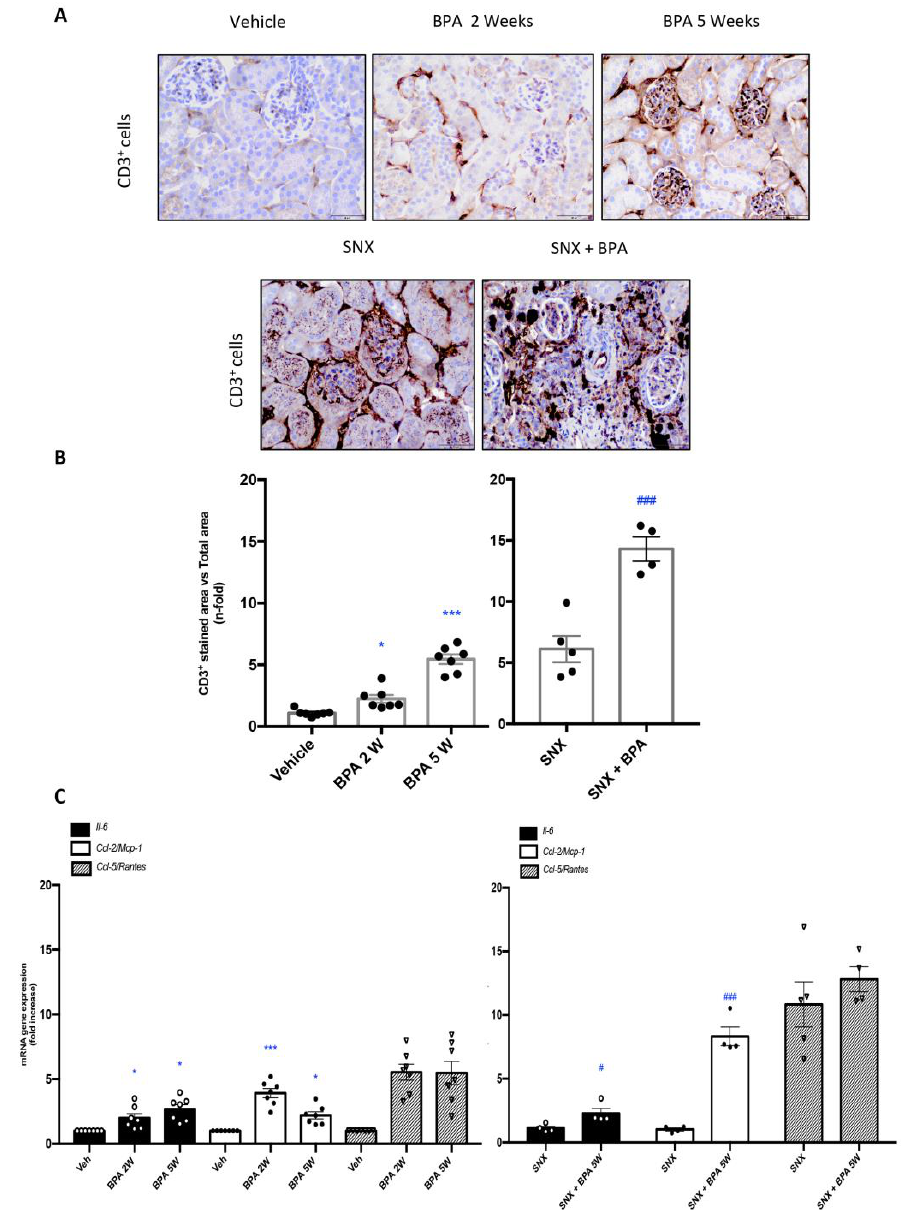
Figure 2. Systemic chronic administration of BPA causes interstitial inflammatory cell infiltration in the kidney and increases renal expression of proinflammatory factors. Animals were intraperitoneal injected with 120 mg/kg/day BPA (5 days a week) or vehicle (corn oil) and sacrificed after 2 or 5 weeks. Some animals were subjected to subtotal nephrectomy (SNX), then treated or not with BPA and sacrificed after 5 weeks. ( A ) Paraffin-embedded kidney sections were stained with an anti-CD3 + antibody. Representative immunohistochemistry pictures identifying inflammatory T cell infiltration (CD3+ T lymphocytes). Magnification 200 X (scale bar appears in lower right area of the image and represents 50 µm). ( B ) Immunohistochemistry staining quantification expressed as mean of stained area vs. total area ± SEM of 4-7 animals per group. ( C ) Gene expression of Il-6, Ccl-2 (Mcp-1) and Ccl-5 (Rantes) were evaluated by RT-PCR. Data are expressed as mean ± SEM of 4-7 animals per group. * p < 0.05; *** p < 0.001 vs. Vehicle, # p < 0.05; ### p < 0.001 vs. SNX. Comparison between SNX and SNX + BPA groups was performed using a parametric unpaired two-sided T test. The analysis of WT vs. BPA-treated groups was done by one-way ANOVA, followed by the Tukey HSD multiple comparison test.